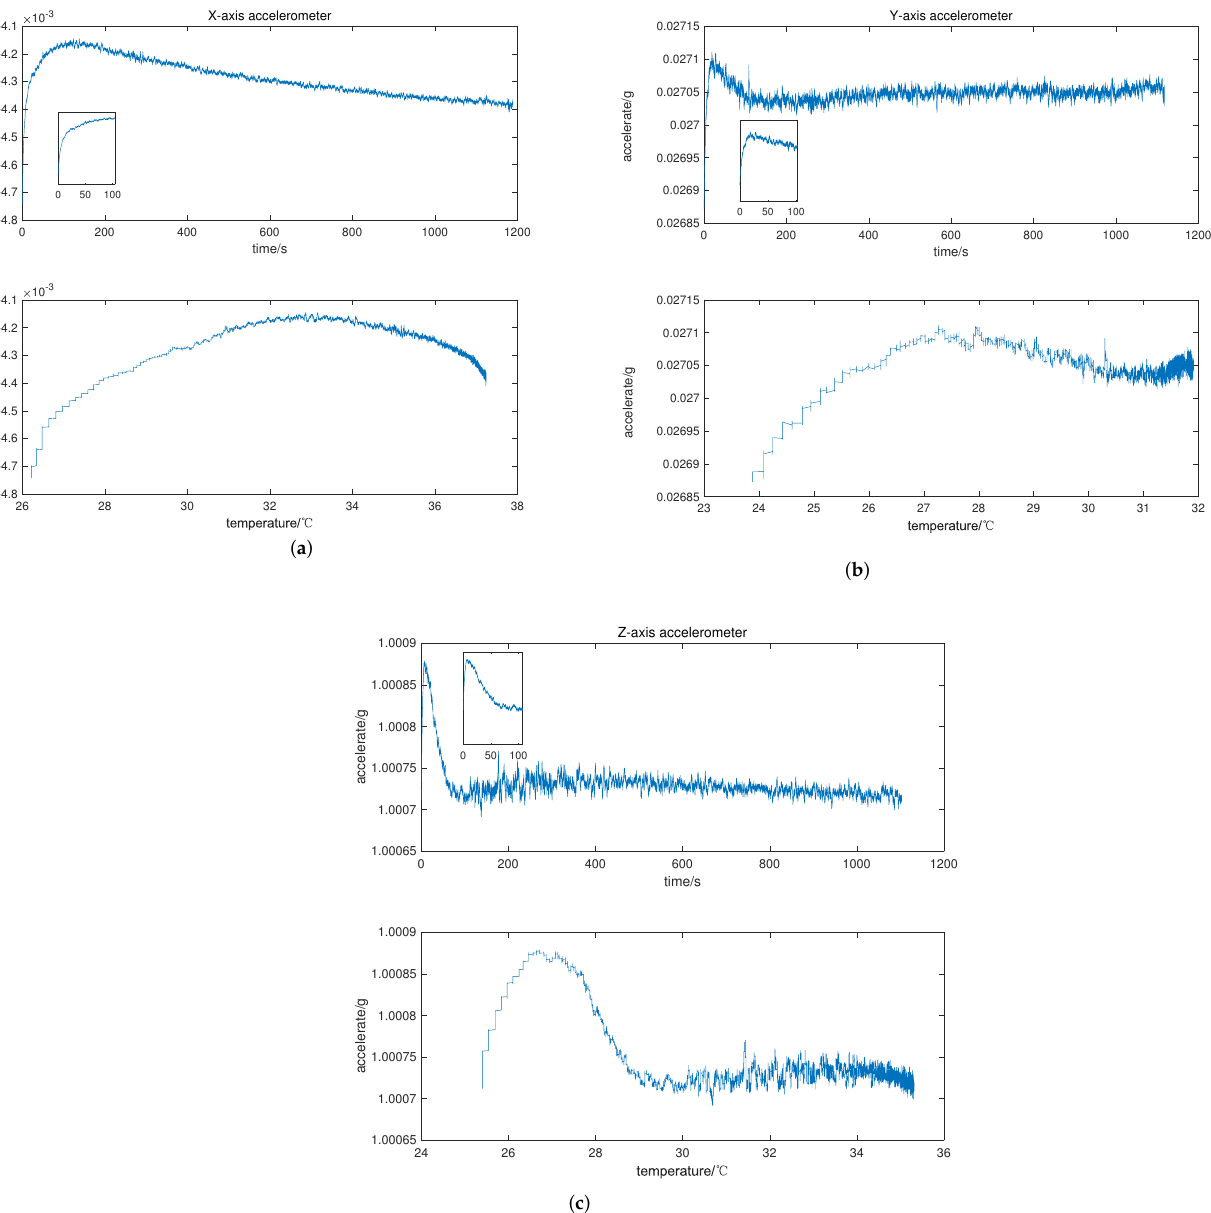
Figure 4. Time- and temperature-domain diagram of three axes for cold start-up phase: ( a ) X -axis accelerometer; ( b ) Y -axis accelerometer; ( c ) Z -axis